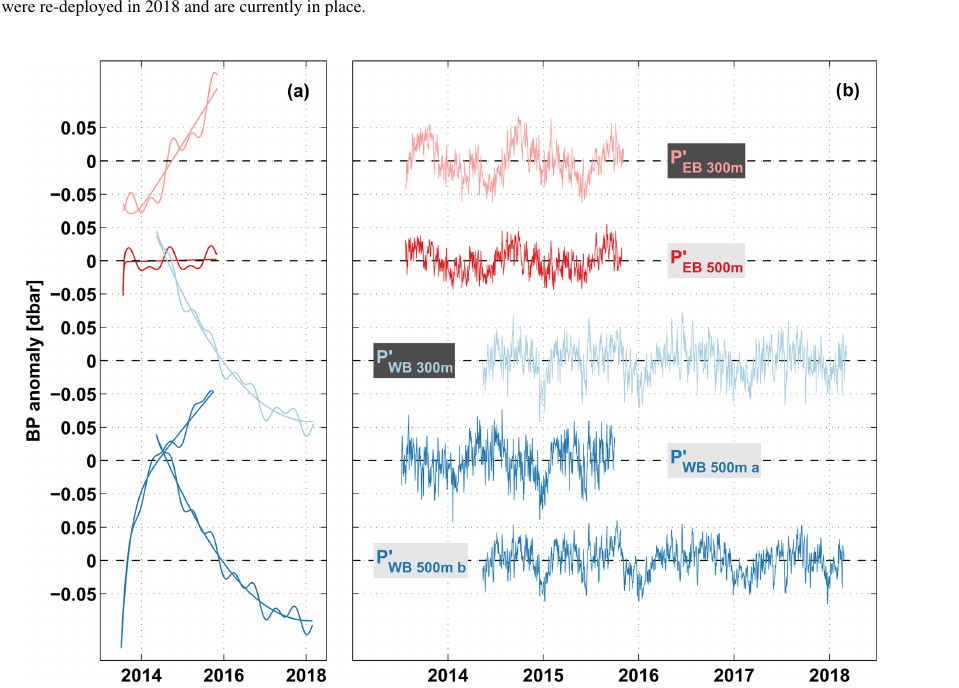
Figure 1. Bottom pressure (BP) anomalies measured at 11 ◦ S off Angola at 300 (pink) and 500m (red), as well as off Brazil at 300 (light blue) and 500m (blue) depth. (a) Instrument drifts that are removed from, as well as the sum of the drift and the combined annual and semi-annual harmonics fitted to, the individual BP anomaly time series. (b) Daily time series of BP anomalies after de-tiding and de-drifting (see text for